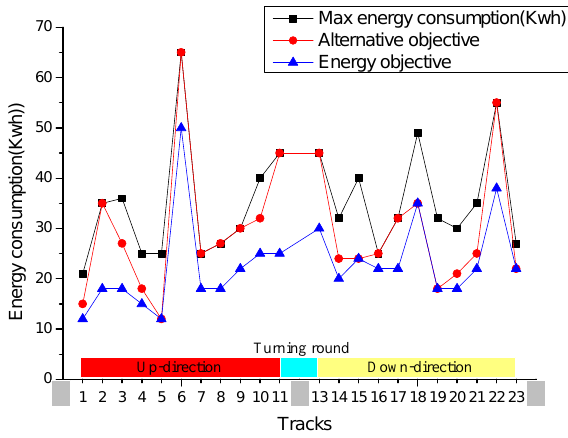
Figure 14. Energy consumption with two different objectives. Table 6. Running time and energy consumption with two different